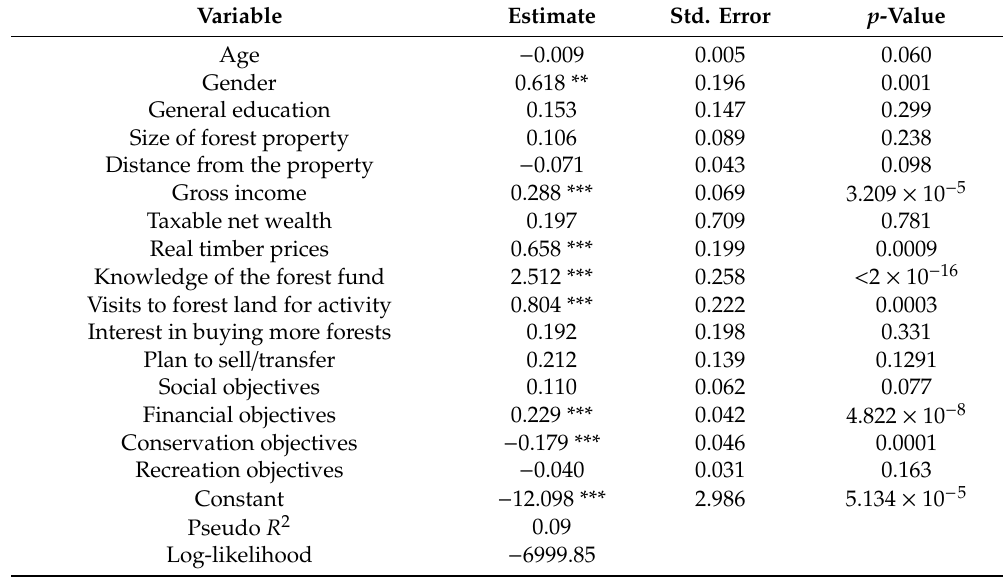
Table 5. Parameter estimates of the tobit model in the period 2003–2012 ( N = 16,370 over 10 years). Variable Estimate Std. Error p -Value Age −